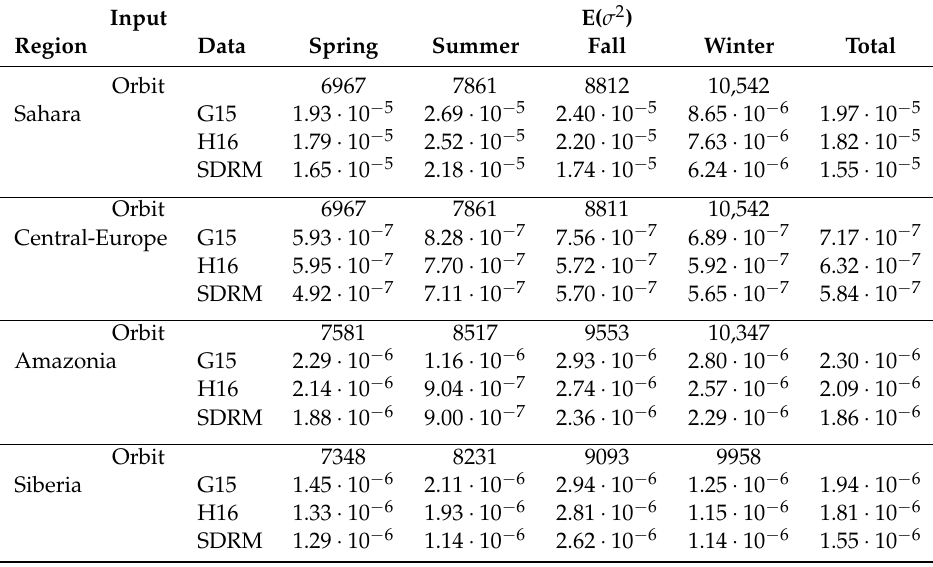
Table 1. Average of the scaled norm of the fitting residuals E( σ 2 ) for individual TROPOMI overpasses in